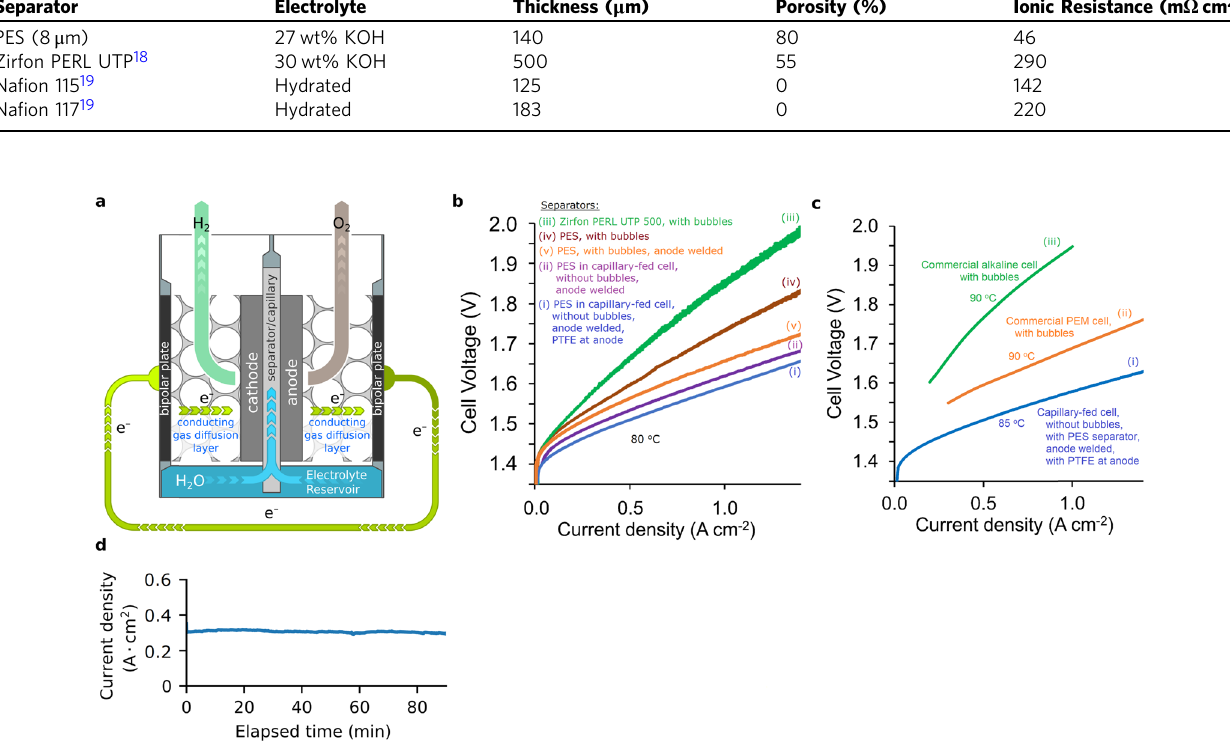
Fig. 3 Capillary-fed electrolysis cell. a Schematic depiction showing how the bipolar plate and conducting gas diffusion layer in the capillary-fed cell were combined into a single bipolar plate structure that comprised a sheet of Ni with many small holes to allow evolved gases to exit the electrode. The anode electrode was welded to its bipolar plate. The cathode was compressed against its bipolar plate and not welded. Supplementary Fig. 6 provides a picture of the cell used. b Polarisation curves of capillary-fed electrolysis cell and controls (80 °C). Plots of (2-electrode) cell voltage vs. current density, from bipolar plate to bipolar plate across the cell, excluding cathodic oxygen depolarisation, of cells with identical NiFeOOH anodes and Pt/C cathodes, at 80 °C, of: (i) Capillary-fed cell with PTFE at the anode, (ii) Capillary-fed cell without PTFE at the anode, (iii) control, conventional, bubbled cell with Zirfon PERL UTP 500 as inter-electrode separator, (iv) control, conventional, bubbled cell with polyether sulfone fi lter (8 μ m average pore diameter) as inter-electrode separator, and (v) control, conventional, bubbled cell with polyether sulfone fi lter (8 μ m average pore diameter) as inter-electrode separator, where the anode is welded to its bipolar plate. c Comparison of capillary-fed electrolysis cell (85 °C) with commercial alkaline and PEM electrolysis cells (90 °C) representative of the state-of -the-art. Polarisation curves of: (i) the capillary-fed electrolysis cell with PTFE at the anode at 85 °C, (ii) commercial alkaline electrolysis cell at 90 °C 24 representative of the state-of-the-art, and (iii) commercial PEM electrolysis cell at 90 °C 20 representative of the state-of-the- art. d Performance of capillary-fed electrolysis cell at a fi xed 100% energy ef fi ciency (HHV) (85 °C). (i) Current density at 85 °C of the capillary-fed electrolysis cell in Fig. 3c(i) when poised at a fi xed cell voltage of 1.47 V, which equates to 100% energy ef fi ciency (HHV). Supplementary Fig. 10 provides data from 1-day and 30-day tests at 80 °C and room temperature, with a large reservoir that was regularly manually Figure 3a depicts a schematic of the cell. Polyether sulfone fi lters of much smaller pore diameter have been previously tested as inter-electrode separators in water electrolysis cells 21,22 .